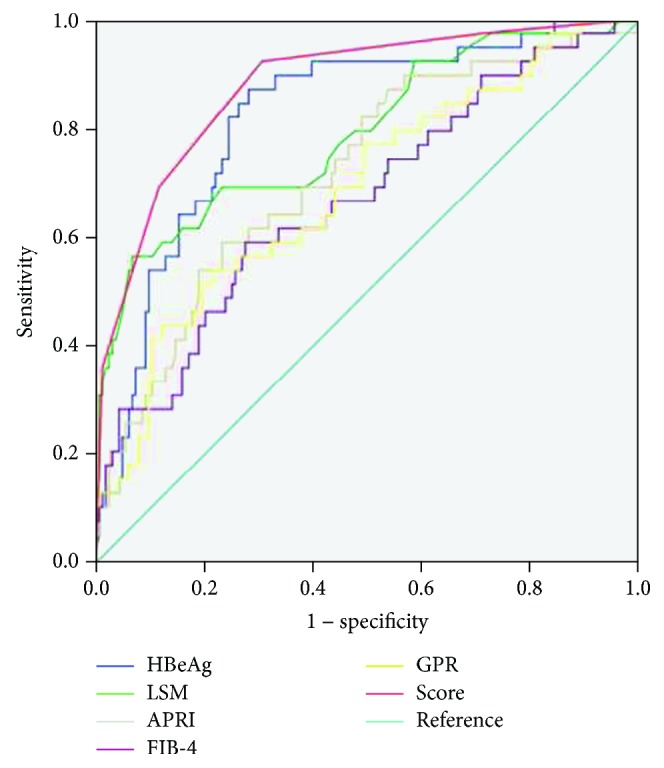
Comparison of the receiver operating characteristic curves of the score with HBeAg, LSM, aspartate aminotransferase- (AST-) to-platelet ratio index (APRI), fibrosis index based on 4 factors (FIB-4), and gamma-glutamyltranspeptidase-to-platelet ratio (GPR) for predicting significant from nonsignificant liver fibrosis in the training group patients.